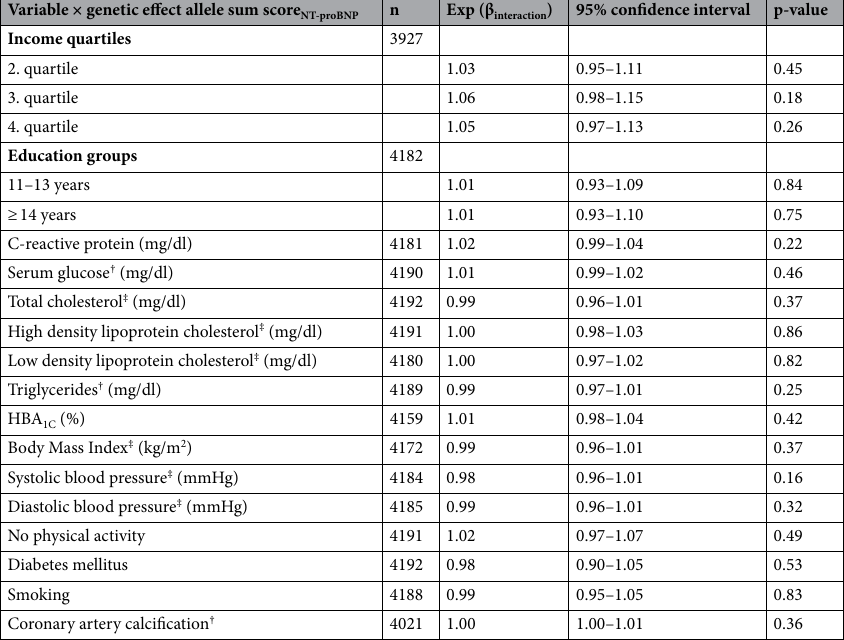
Table 6. Exp(β interaction ) and 95% confidence intervals (95% CI) of the interaction term for the interaction of socioeconomic and cardiovascular risk factors by the NT-proBNP-related genetic risk allele sum score on NT-proBNP in separate linear regression models, separately for each socioeconomic and cardiovascular risk factor, adjusted for sex and age, including only participants with no stroke, no coronary artery disease and glomerular filtration rate > 30 ml/min/1.73 m 2 at baseline (lowest income/education group as reference). ‡ Exp(β) per standard deviation. † Exp(β) per interquartile